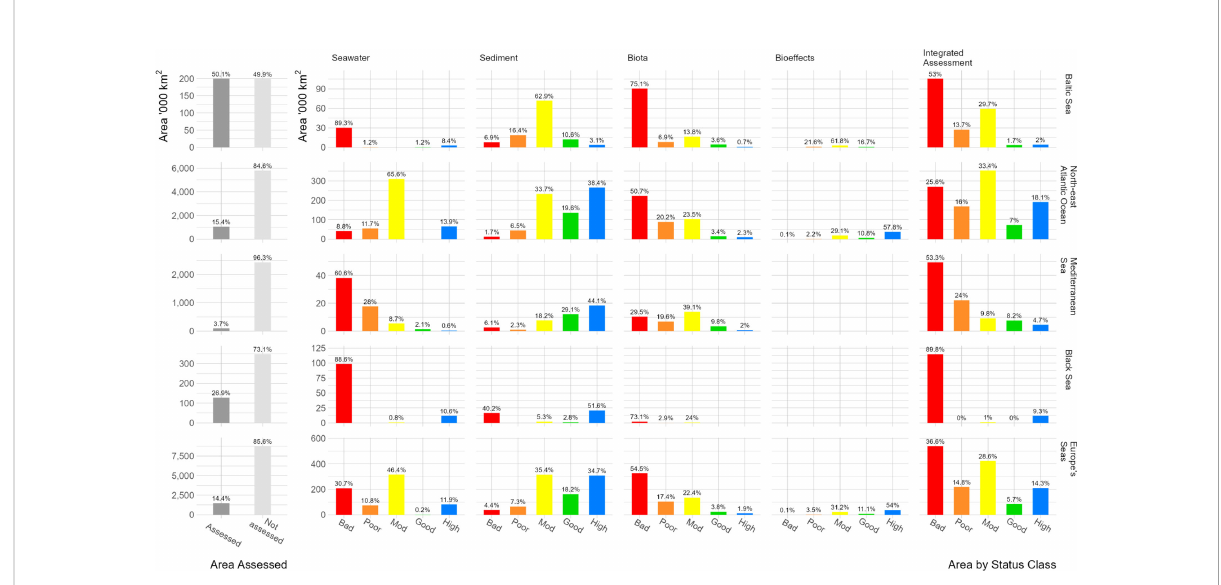
FIGURE 2 Summary of the CHASE classi fi cation in the four regional seas (Baltic Sea, Black Sea, Mediterranean Sea and North-East Atlantic Ocean). The results are categorised into fi ve classes, where 'non-problem areas' are presented as NPA high and NPA good and 'problem areas' as PA moderate , PA poor and PA bad . See Figure 1 for the de fi nition of the fi ve classes. Please note that Figure 3 is based on these